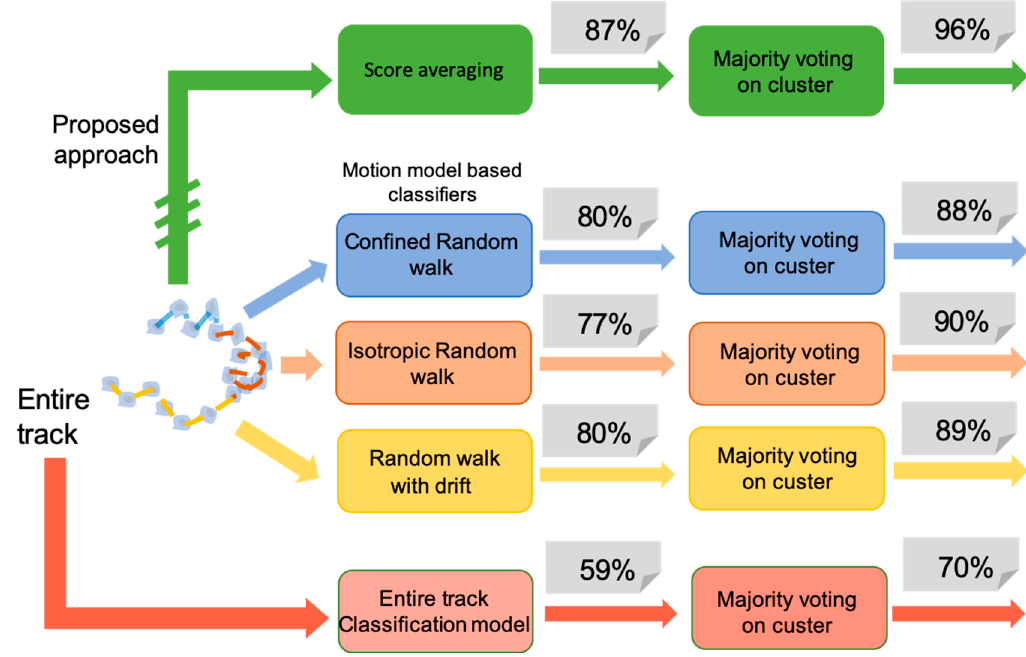
Figure 6. Comparative analysis results. Green boxes at the top indicate the proposed method. The blue, orange and yellow blocks indicate the classifiers constructed on each single motion model, starting from the corresponding sub-tracks of each cell track. Finally, the pink boxes at the bottom indicate the old-paradigm approach in which the entire track is used for the analysis.